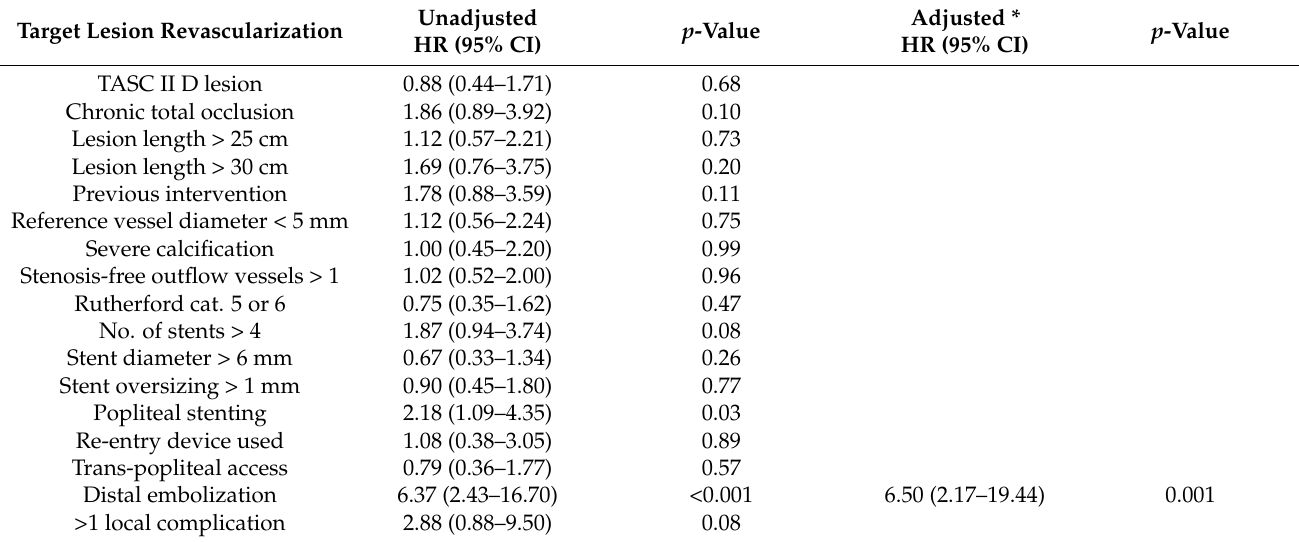
Figure 3. Freedom from target lesion revascularization. Kaplan–Meier estimates presenting freedom from target lesion revascularization (TLR) during the 48-month follow-up, including all technically successful cases ( n = 96). SE = standard error. Table 4. Cox regression analysis of factors associated with target lesion revascularization.